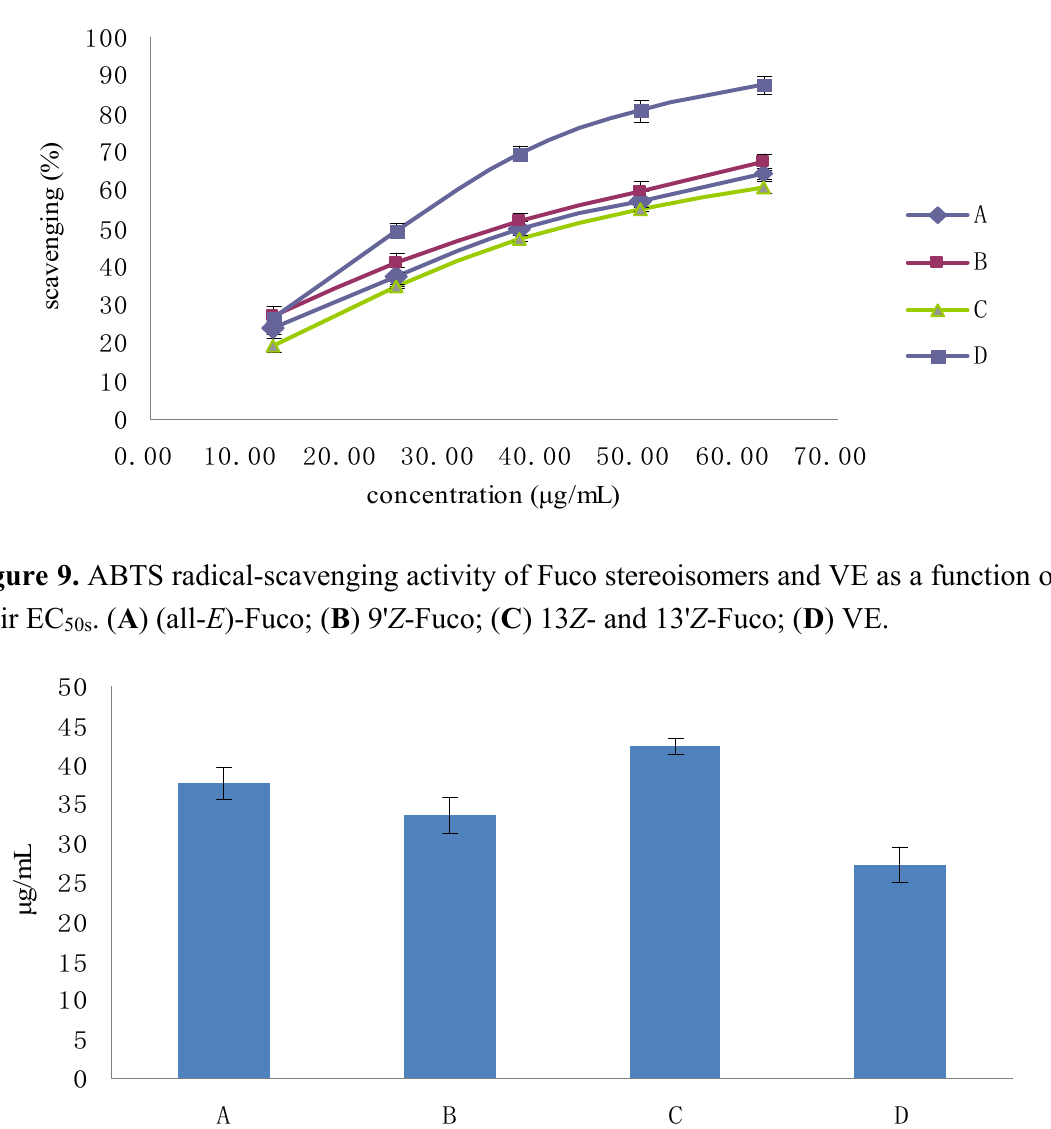
Figure 8. ABTS radical-scavenging activity of Fuco stereoisomers and VE. ( A ) is (all- E )-Fuco; ( B ) is 9' Z -Fuco; ( C ) is 13 Z - and 13' Z -Fuco; ( D ) is VE.